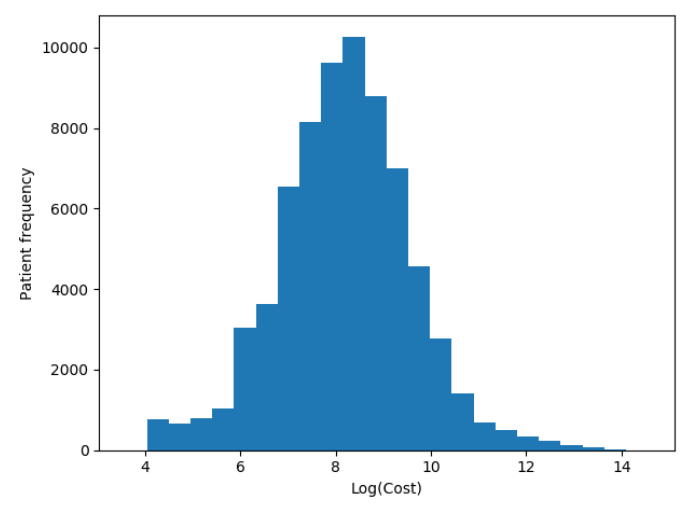
Figure 6. Patients logarithmic costs